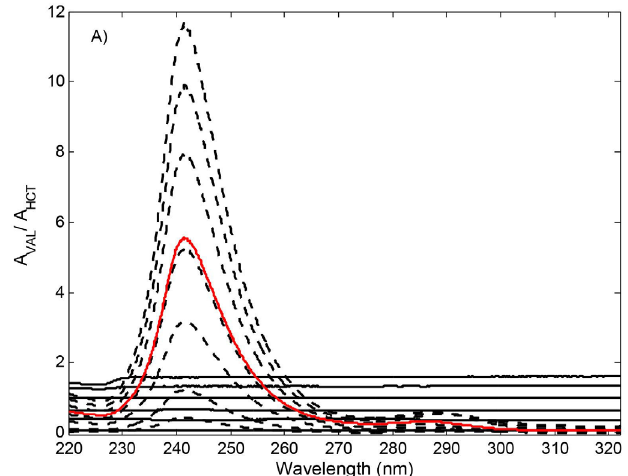
FIGURE 3A - Ratio spectra of VAL/HCT, VAL (----) : 1.0, 3.0, 9.0, 15.0, 21.0, 27.0, 33.0 µ g/mL and HCT (  ) : 1.0, 6.0, 11.0, 16.0, 21.0, 26.0 µ g/mL and tablet sample (  ) containing 2.50 µ g/mL of VAL and 16.0 µ g/mL of HCT.